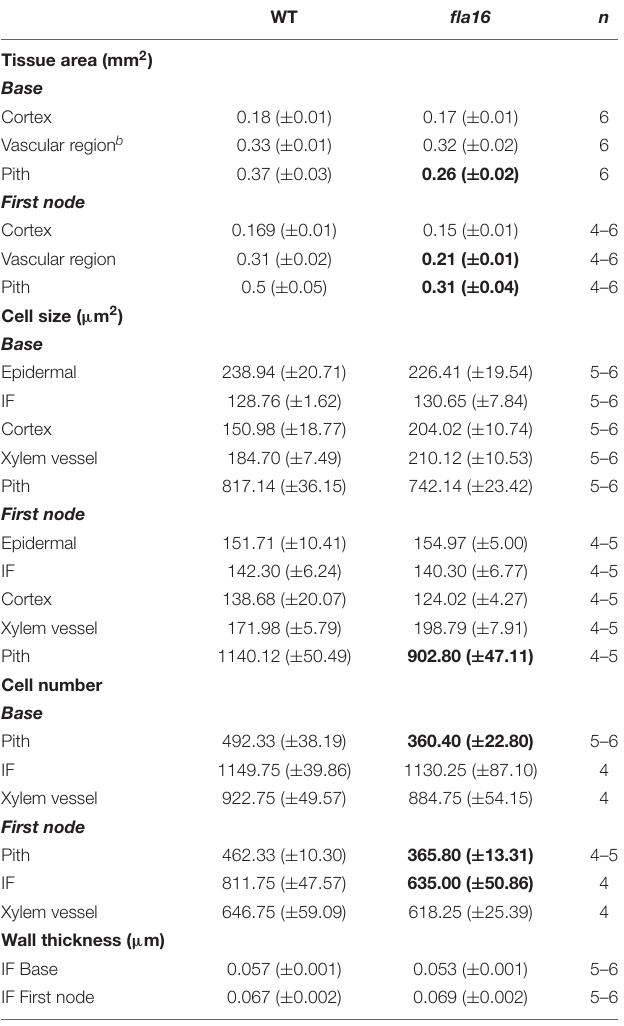
TABLE 2 | Analysis of tissue and cellular morphology in mature stems of WT and fla16 plants a . location of FLA16 would be in the cell wall. Proteins WT fla16 n